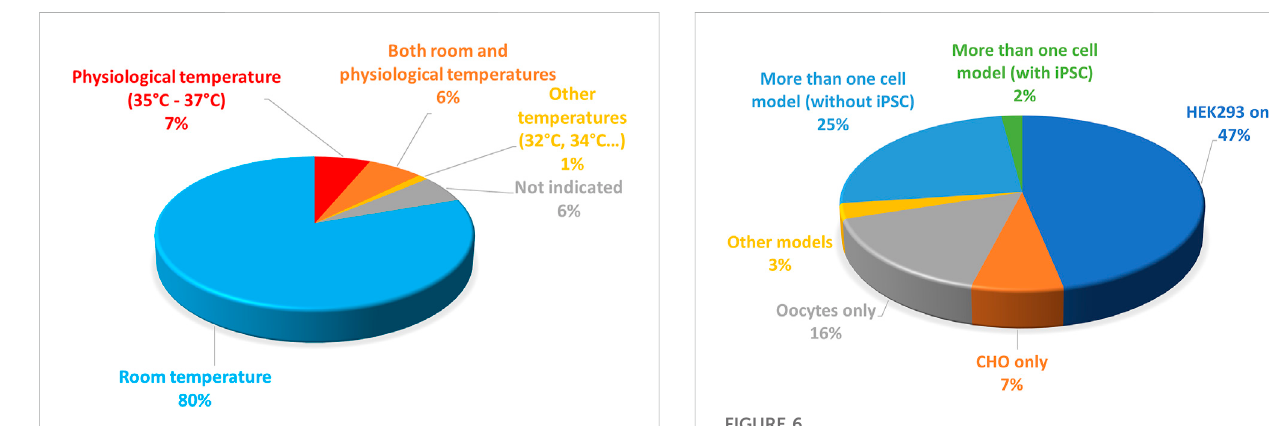
FIGURE 5 Pie chart presenting the percentage of hERG missense variants (among all the published missense variants), studied at room temperature, at physiological temperature, at both temperatures, or particular temperatures (32 ° C or 34 ° C). This chart includes all missense variants studied in patch-clamp experiment performed in mammalian cells (from analysis of Supplemental Table S1).